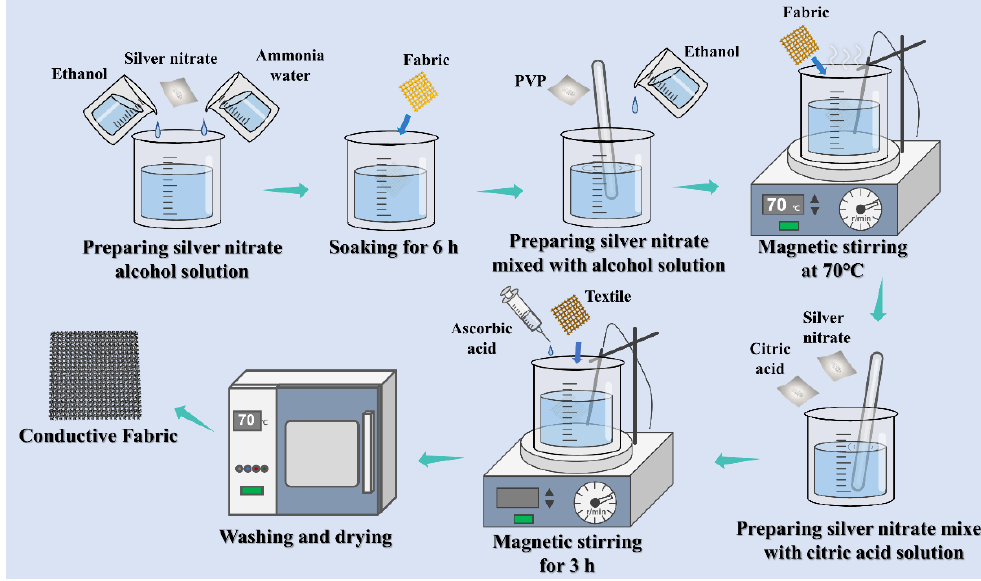
Figure 8. The in situ growth process for the preparation of conductive fabric.